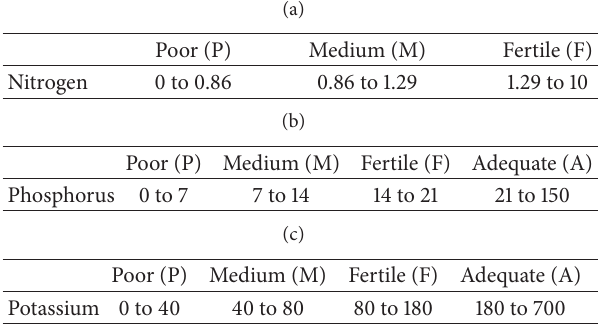
Table 1: Ranges and linguistic values of input surfaces.